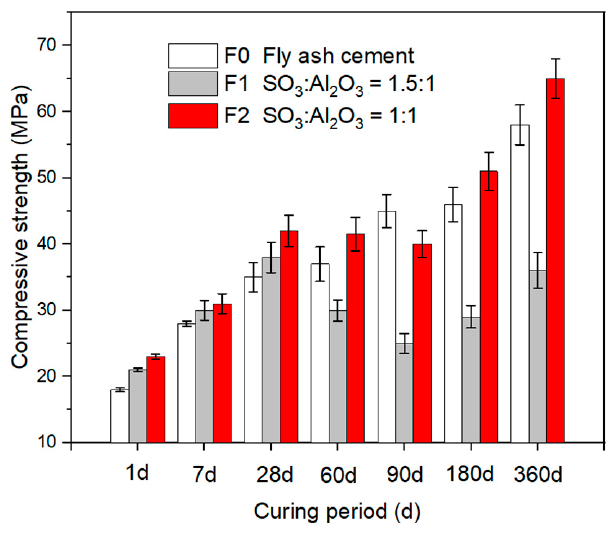
Figure 4. Compressive strength of specimens in steam curing.